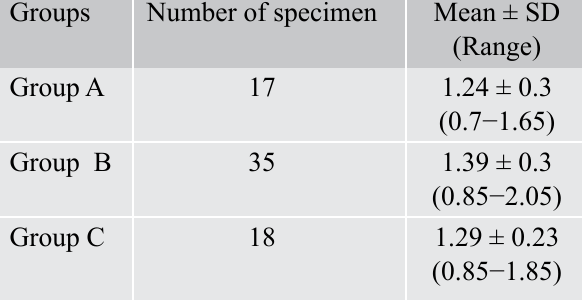
Table II: Comparison of luminal diameter of the trachea among the age groups Comparison